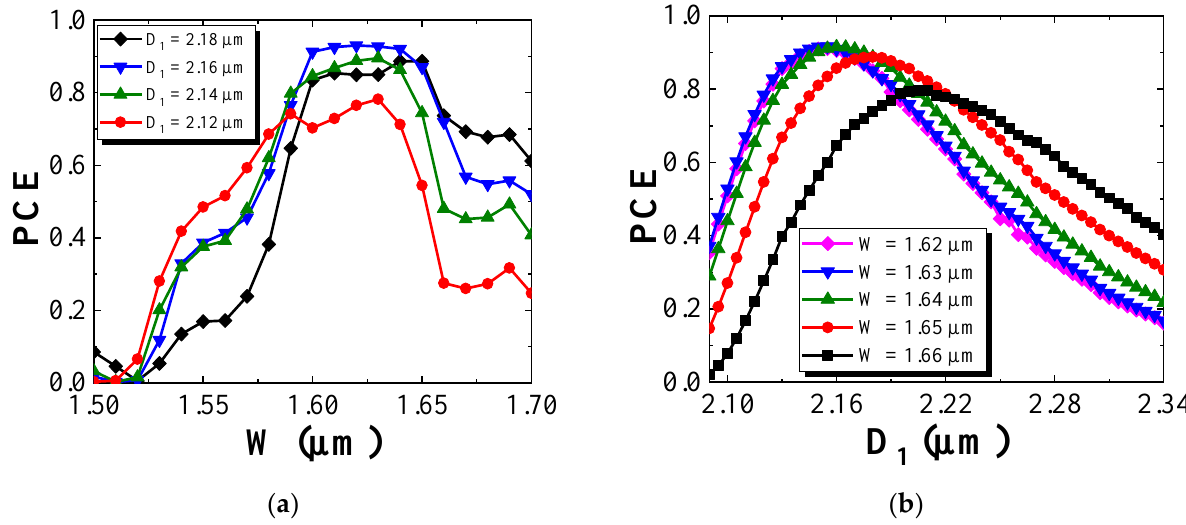
Figure 10. Maximum PCE with respect to ( a ) the waveguide width W and ( b ) the shallow etched depth D 1 for a PMC length of 1250 μm .